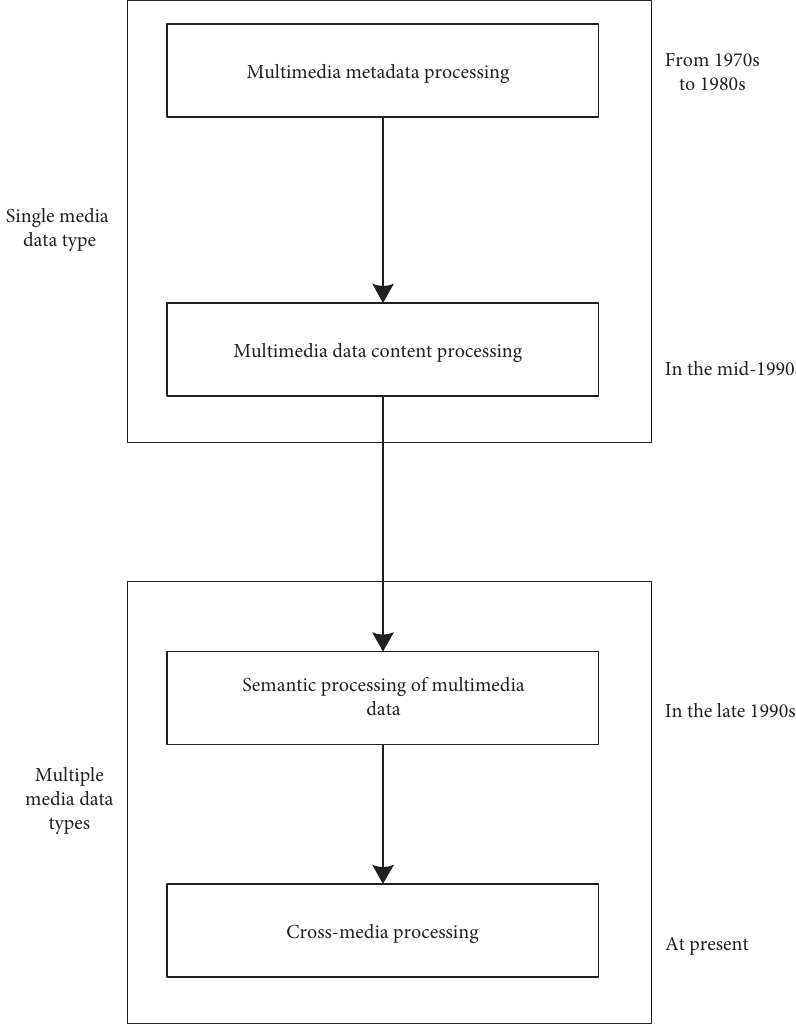
Figure 2: Development of the multimedia data processing